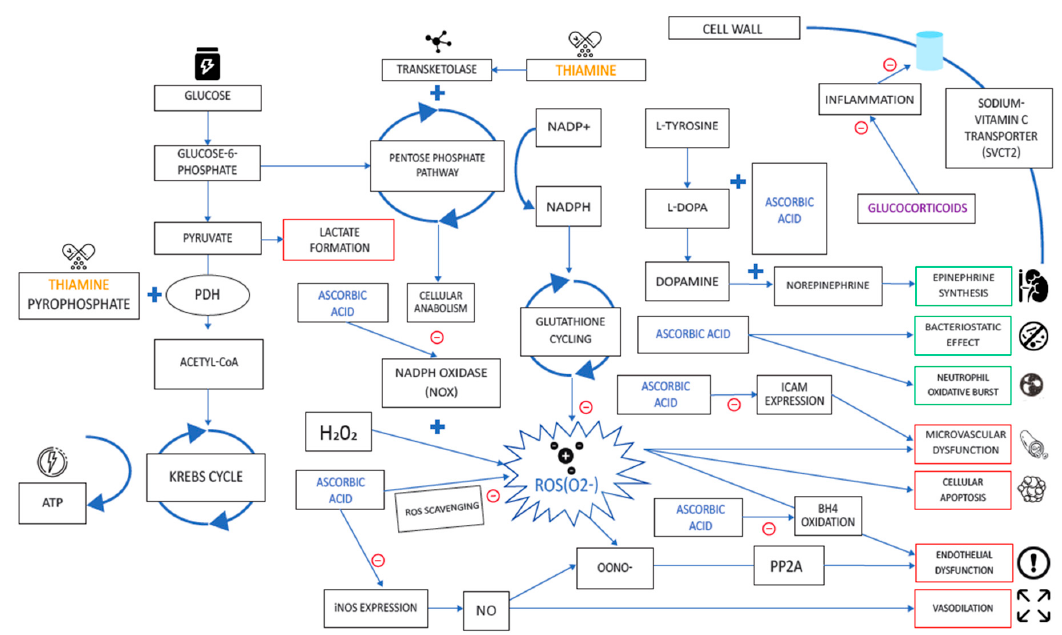
Figure 5. Thiamine and its derivatives act synergistically with ascorbic acid to reduce anaerobic respiration and reduce oxidative stress. It has been suggested this combination may improve mortality and organ recovery in critically ill patients with septic shock through vasoactive effects, bacteriostatic action, and immune cell mediation. The significance of these actions on viral infections, such as COVID-19, remain to be elucidated.